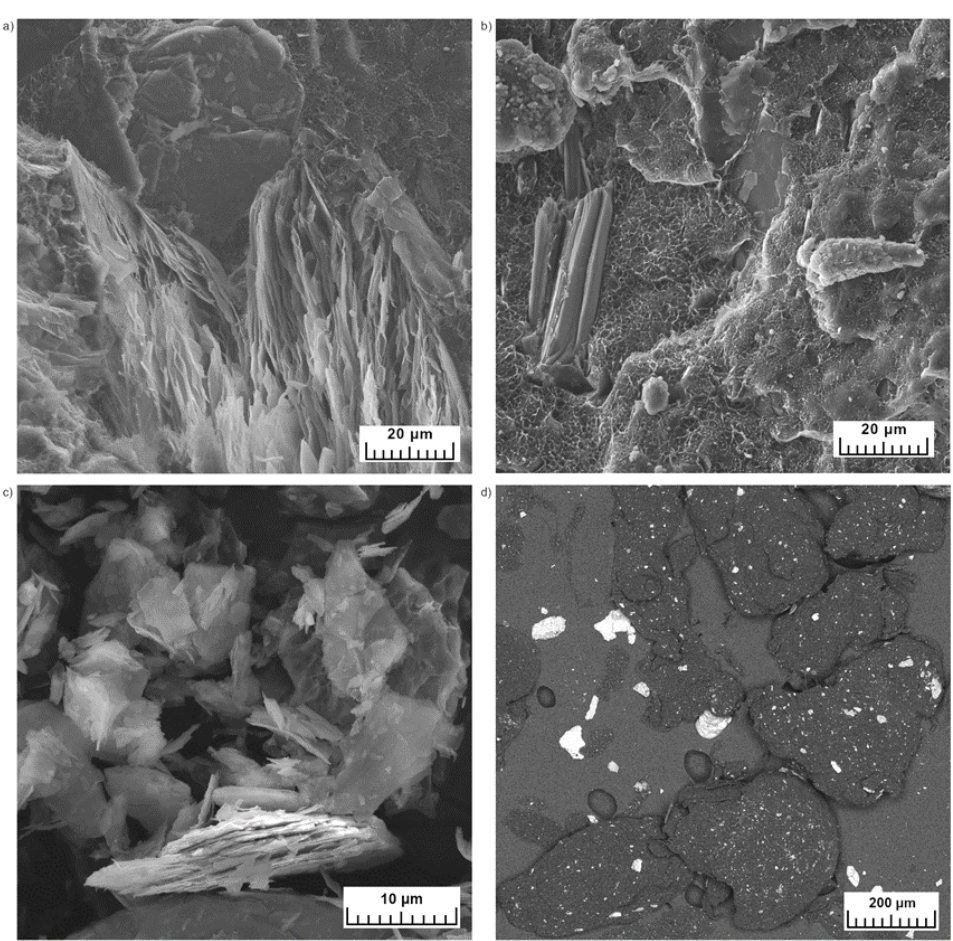
Figure 7. SEM images of cryo-fractured rotomolded composite with 2 wt% dry blended ( a ) and melt compounded ( b ); expanded vermiculite ( c ) and composite powder containing 10 wt% in the BSE mode ( d ).